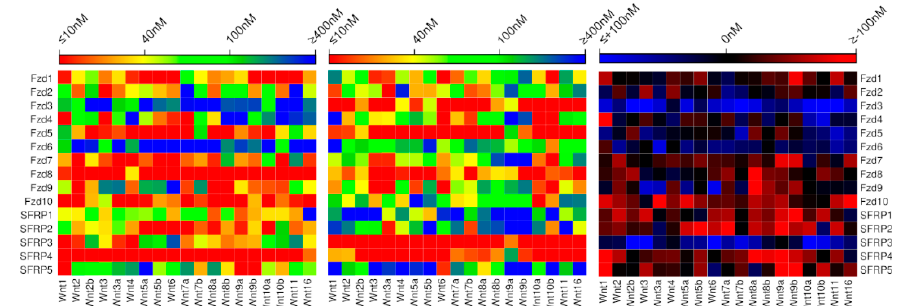
Figure 3. Comparison of binding affinities for all human Wnt ‒ Fzd and Wnt ‒ sFRP interactions predicted by the new model ( left ) and the previously published model ( center ), with differences between the models enumerated ( right ).